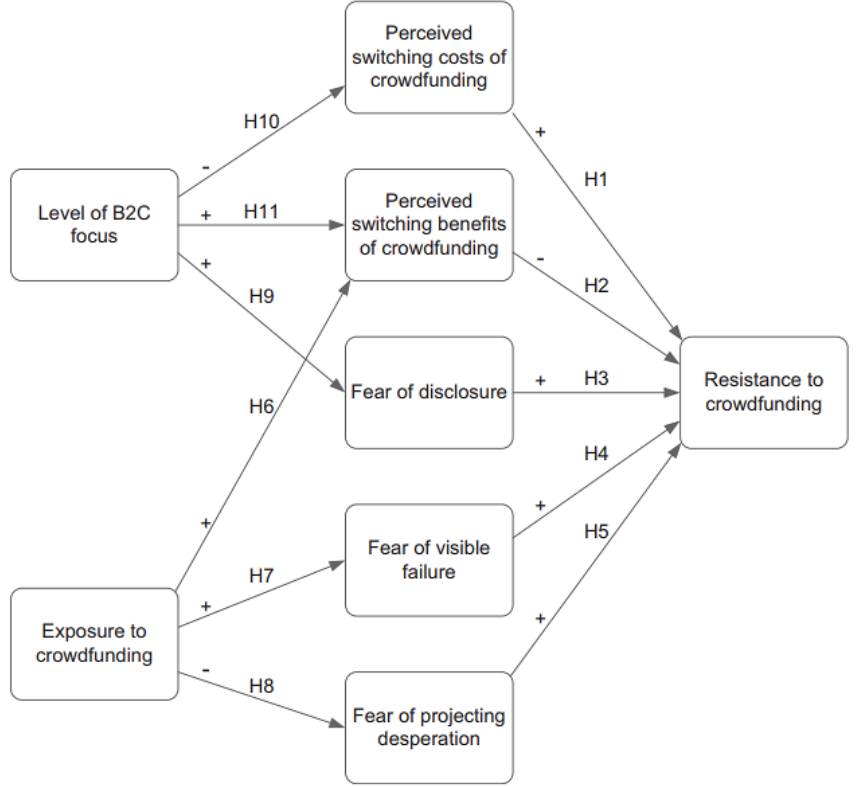
Figure 6. The proposed model for entrepreneurs’ resistance against crowd funding